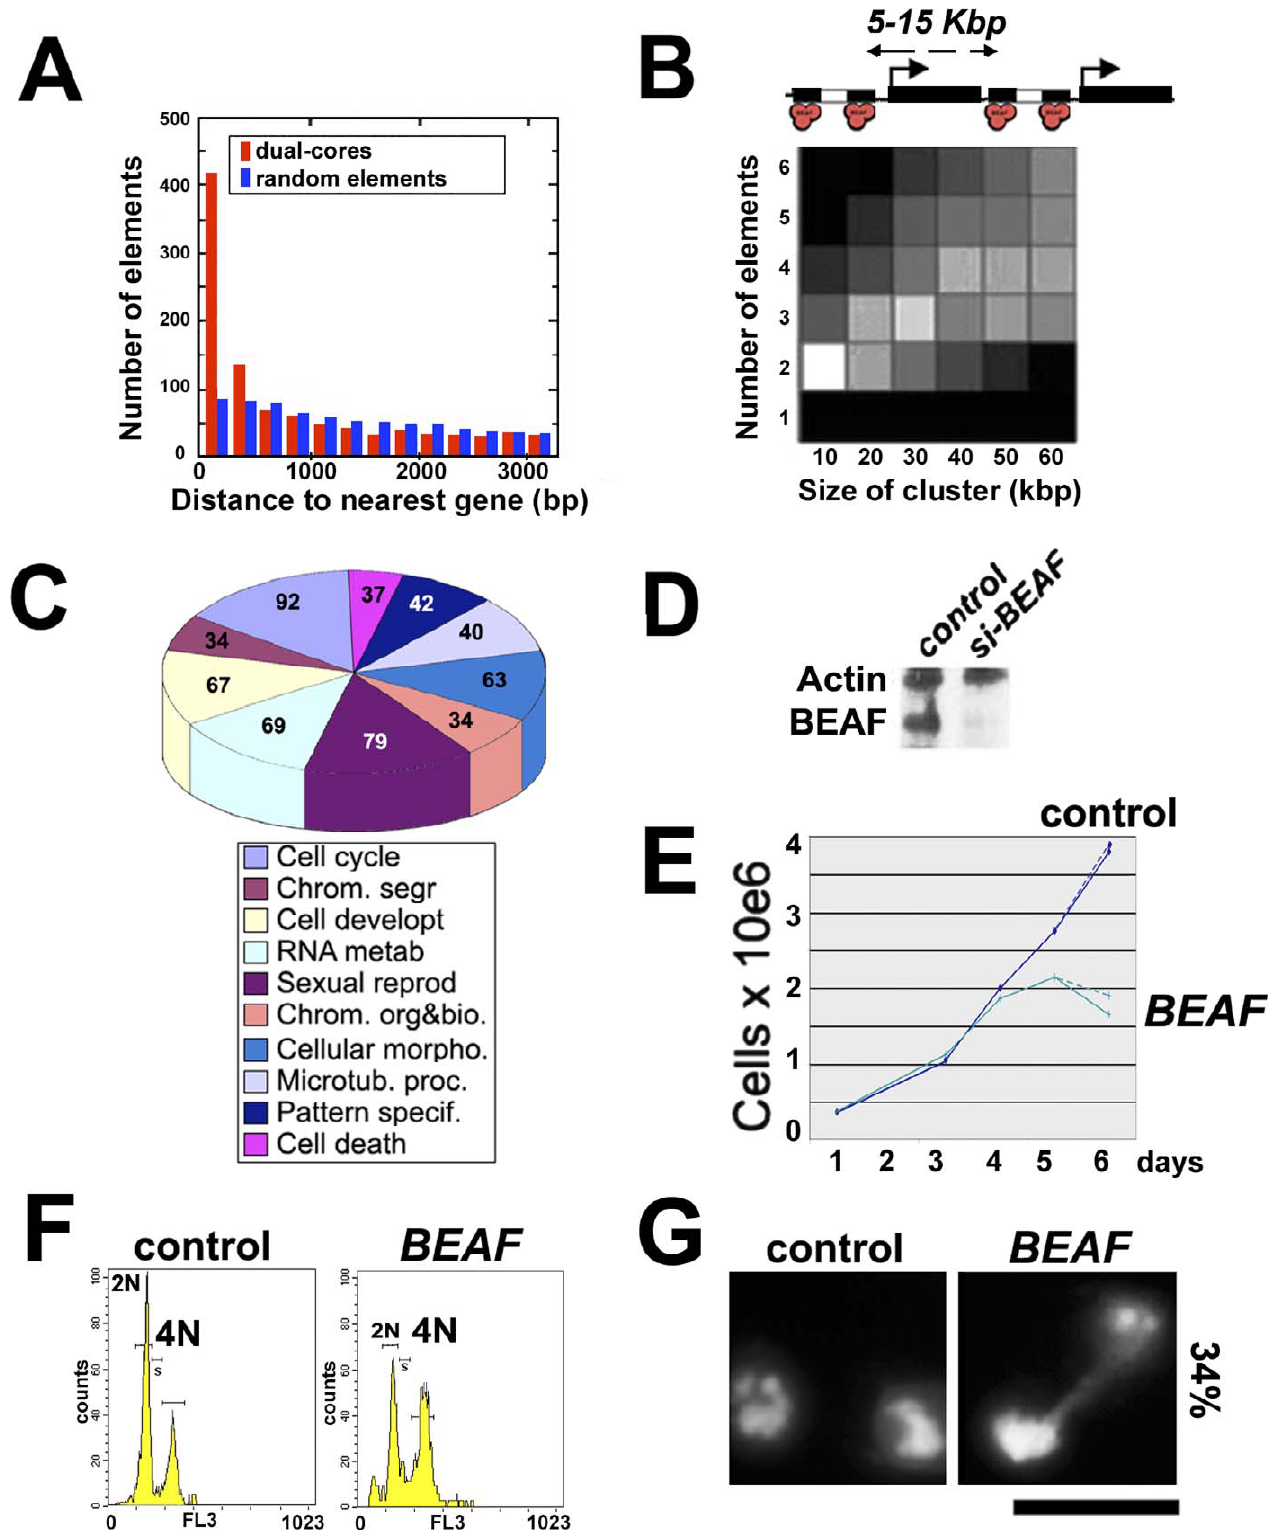
Figure 3. Genomic Features Associated with BEAF Dual-Cores (A) Distribution of the distances between TSSs and dual-cores (red) compared to a theoretical distribution for randomly placed elements (blue) (see Materials and Methods). y -Axis, number of dual-cores; x -axis, distance to the nearest gene (in bp). (B) Statistical analyses of the distribution of dual-cores. Dual-cores are preferentially organized in pairs separated by 5–15 Kbp as depicted on top (white square: p -value ¼ 1.01e-33) most likely due to the organization of genes in clusters (see text). y -Axis, number of dual-cores; x -axis, distance between two dual-cores. Lighter (/darker) boxes represent the most (/less) significant p -values (see Materials and Methods).